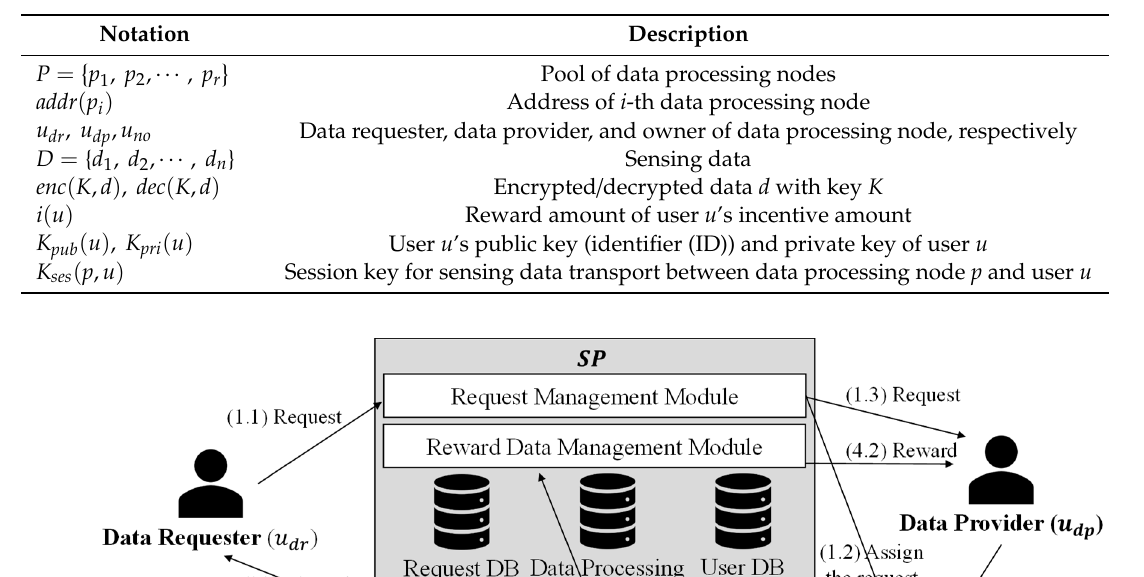
Table 2. Table of notations.